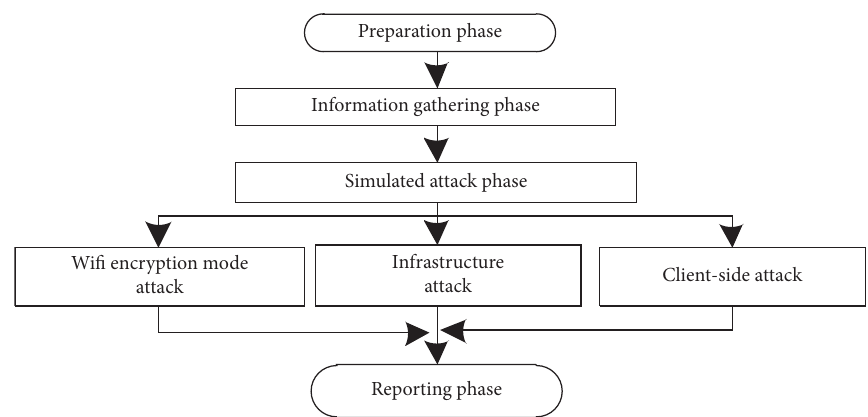
Figure 1: WiFi penetration test